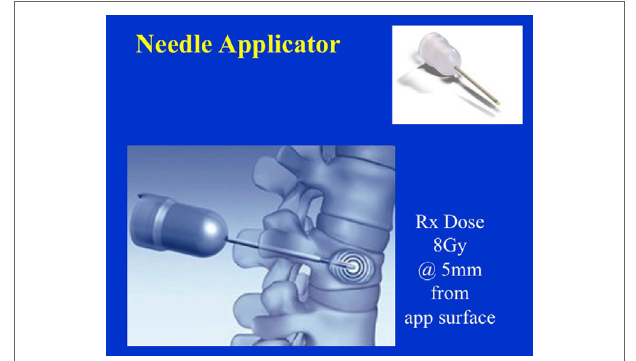
FigUre 12 | Dose distribution from a needle applicator. Dose is prescribed at 5 mm from the applicator surface or 8 mm from the source. Needle applicator shown in